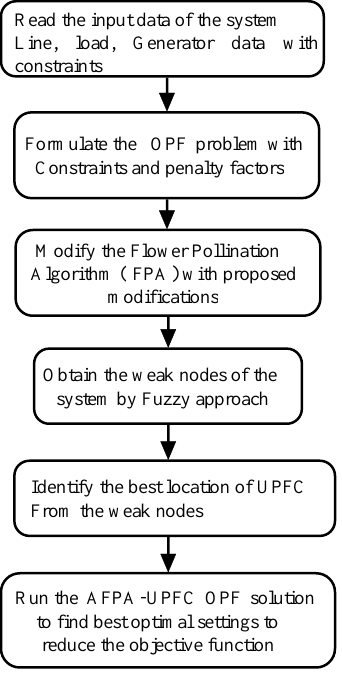
Figure 1. Proposed AFPA block